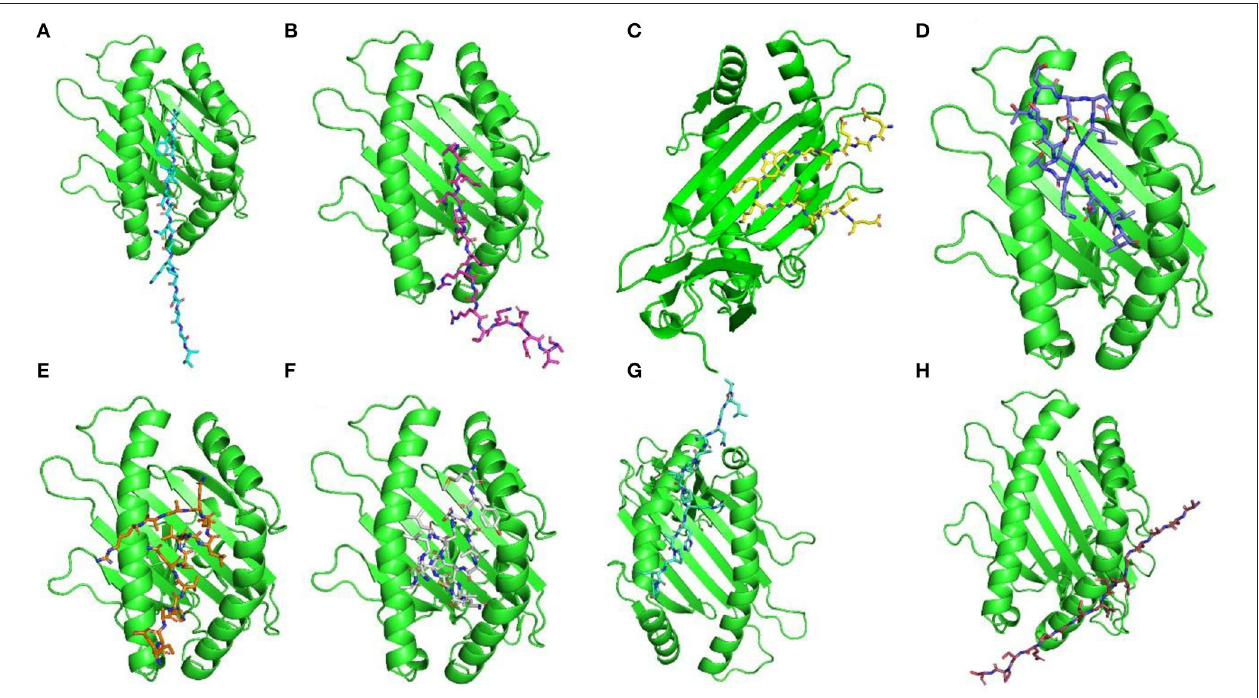
FIGURE 2 | Docking complexes of selected HTL epitopes with corresponding HLAs. Here (A) shows AFGLVDSNGKPSAAV + HLA-DRB4*01:01, (B) shows VINPNLRGRTKEEVA + HLA-DRB4*01:01, (C) shows EAEVPWAFKGKTYLE + HLA-DRB4*01:01, (D) shows SSTDEELGKTERELL + HLA-DRB3*01:01, (E) shows